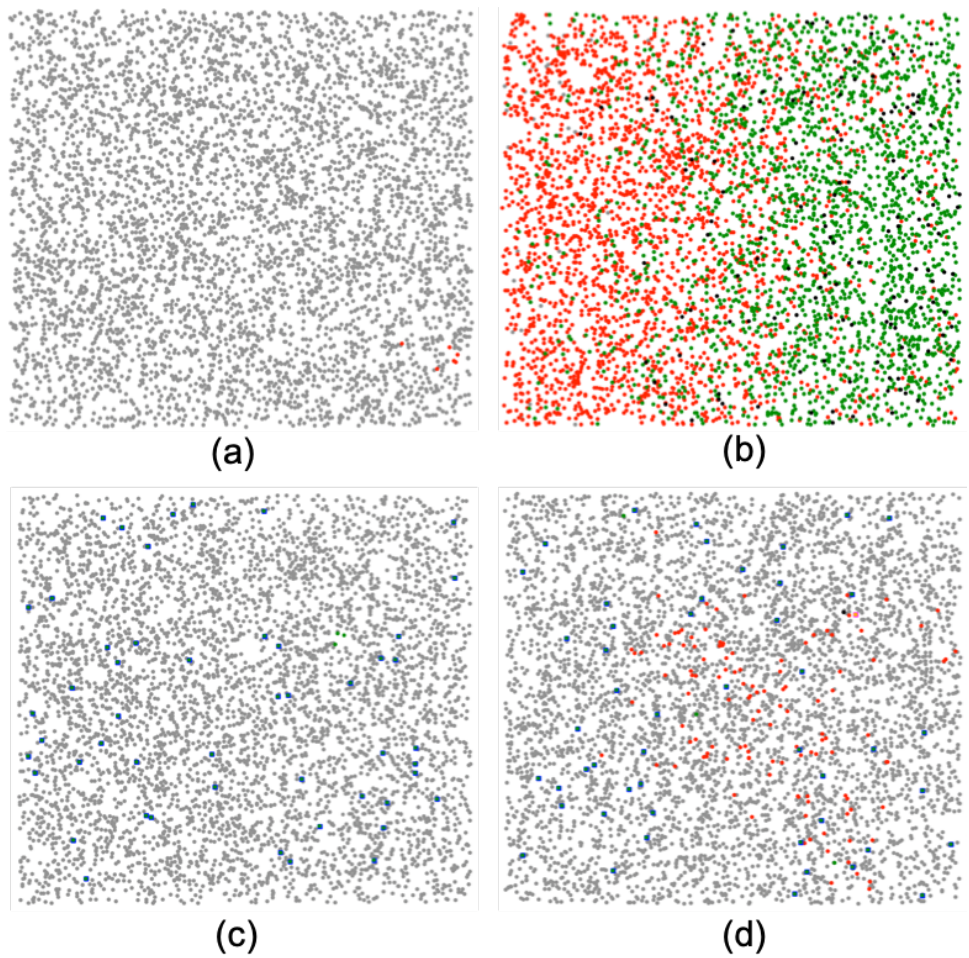
Figure 3. A visualized simulation process, where ( a , b ) show the benchmark scenario in the initial and intermediate phases, respectively; and ( c , d ) shows the users and objects deployed in the initial and intermediate phases, respectively. User states are indicated in dots with healthy (in gray dots), infectious (in red dots), recovered (in green dots), and fatality (in black dots) states. UEs are shown in blue